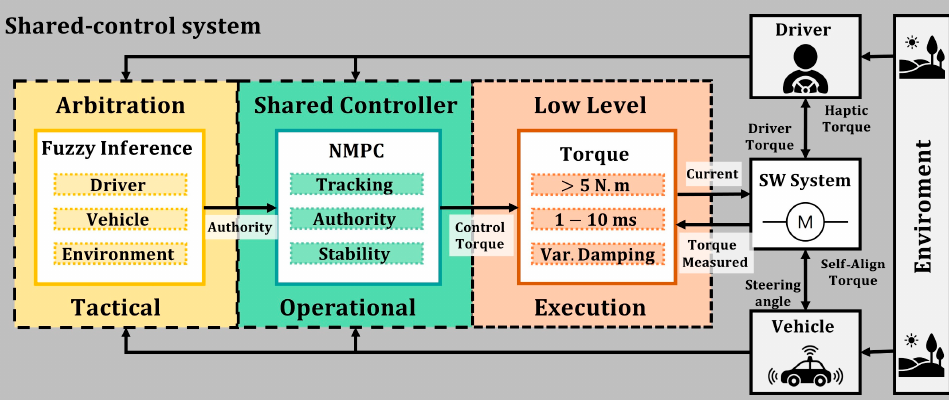
Figure 6. Shared control framework for Automated Vehicles.